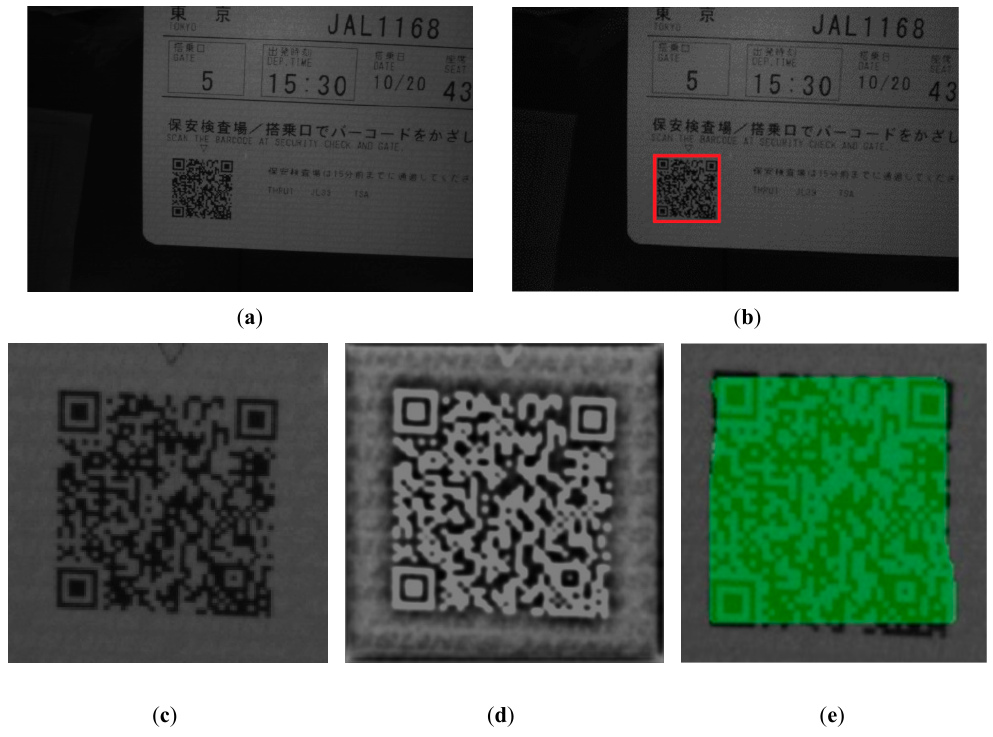
Figure 10. A prediction example of MU R-CNN. ( a ) Input image. ( b ) Bounding box predicted by Mask R-CNN branch; ( c ) The candidate image segmented from the input image, and for blurry image, the texture of QR tag is usually not clear enough; ( d ) Instance mask of MU R-CNN network prediction output; ( e ) Instance mask of Mask R-CNN network prediction output.